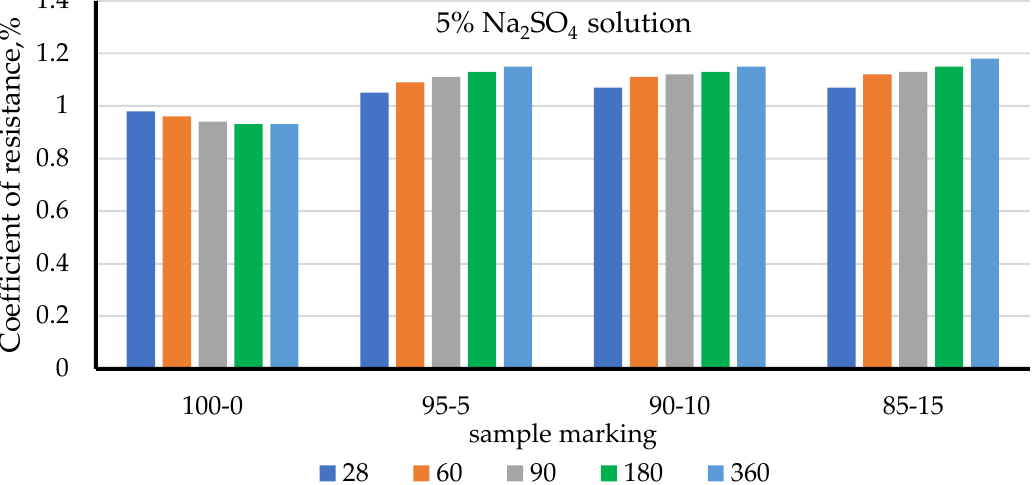
Figure 10. The coefficients of corrosion resistance of the mixed cement samples during different periods (days) of hardening in 5% Na 2 SO 4 solution.